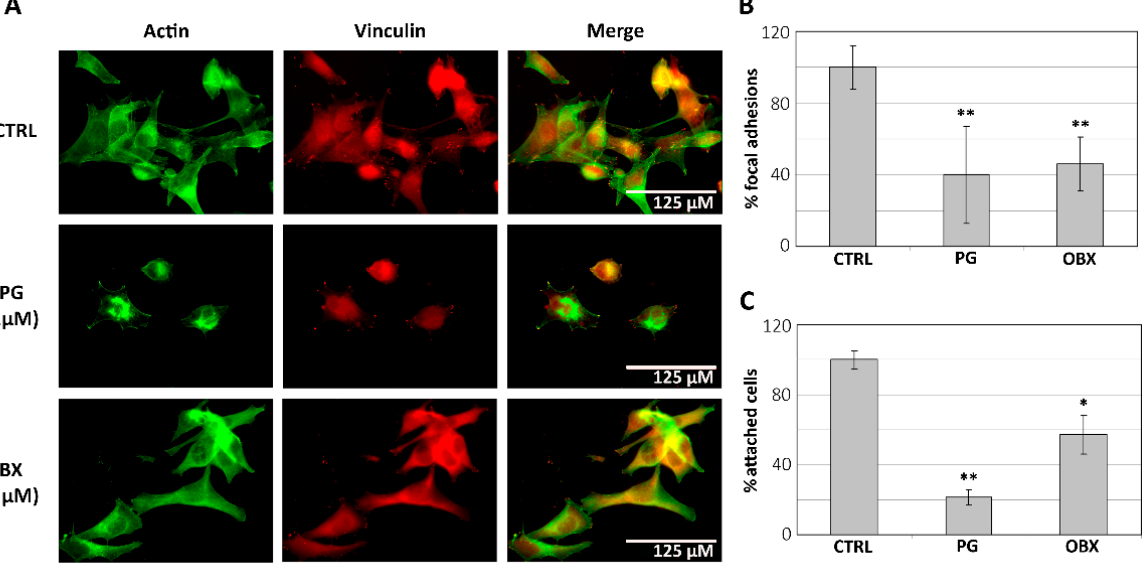
Figure 2. Focal-adhesion evaluation after PG or OBX treatment in SK-MEL-5 ( A – C ) and in SK-MEL- 28 ( D – F ). Immunofluorescence of vinculin (red) and actin (green) shows focal adhesions in SK-MEL- 5 (A) and SK-MEL-28 ( D ) cells after 3 h of treatment with PG (1 or 4 µM, respectively) or OBX (10 µM). The percentage of focal adhesions ( B , E ), as well as the percentage of cell attachment ( C , F ), were quantified. Figure shows mean ± SD. Statistical differences from control (CTRL) are shown as ** p < 0.01 and * p < 0.05. 3.2. PG Treatment Decreases Cellular Migration To deeply characterize the PGs’ antimetastatic effects, especially those related to cell- migration ability, we analyzed PGs’ effects on cancer cells’ motility through the wound- healing assay. The human SK-MEL-5 and -28 melanoma cell lines do not grow to a con- fluent monolayer; thus, it is not possible to accurately evaluate antimigratory PGs’ effects on these cells through wound-healing assay. Hence, the B16F10 mouse melanoma cells and the other human cancer cell line, HN4, were used to perform this assay. The B16F10 were grown to a confluent monolayer and a scratch was applied with a sterile tip. Next, they were exposed to non-toxic concentrations of PGs in three different experimental